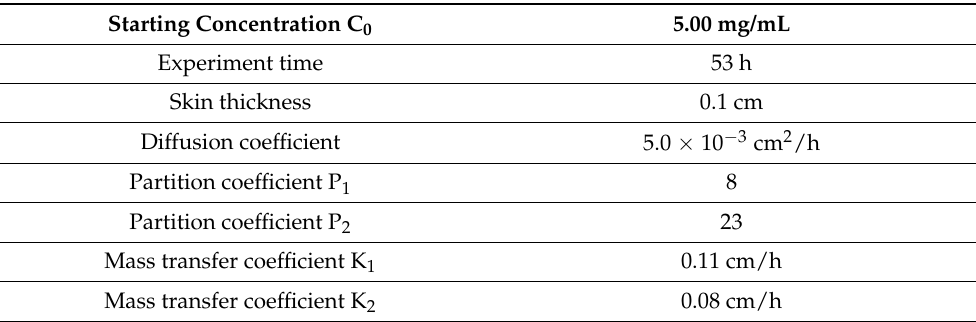
Table 4. Estimated parameter values for simulations of caffeine at 32 ◦